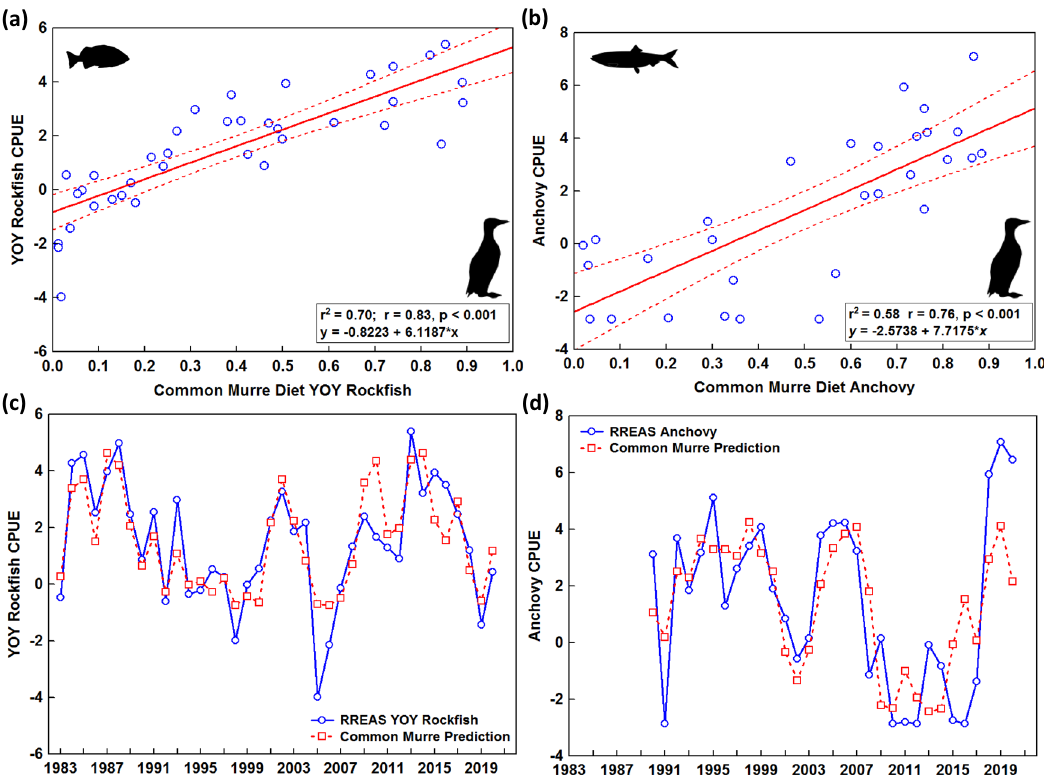
Fig. 3 A seabird diet and ecosystem indicator model. a Functional relationship between YOY Rock fi sh CPUE (catch-per-unit-effort) log abundance index and mean proportion of YOY rock fi sh in seabird (common murre) diet; 1983 – 2019. b Functional relationship between adult northern anchovy CPUE log abundance index and mean proportion of anchovy in seabird (common murre) diet; 1990 – 2019. Dashed lines in a , b are 95% con fi dence intervals. c , d Prediction of YOY Rock fi sh and anchovy abundance index from the seabird regression model (dashed line) compared to log(CPUE) from the delta-GLM (points). Taxa silhouettes are derived from